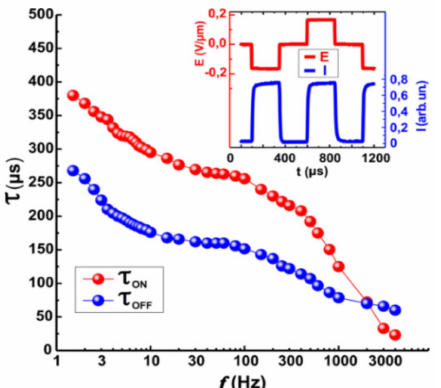
Figure 8. Frequency dependence of electrooptical response times τ ON and τ OFF of the DHFLC cell based on FLC-618, d = 107 µ m, T = 23 ◦ C. The inset illustrates the applied voltage and electro-optical response waveforms.